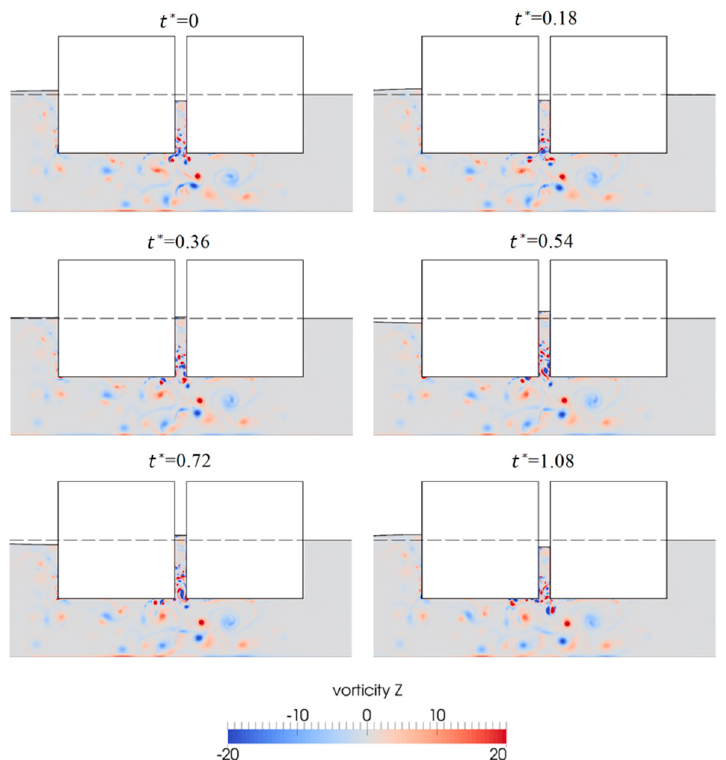
Figure 9. The variations of the vorticity contour in the water phase for Case C9 (incident wave frequency larger than the resonance frequency) at different time instants.